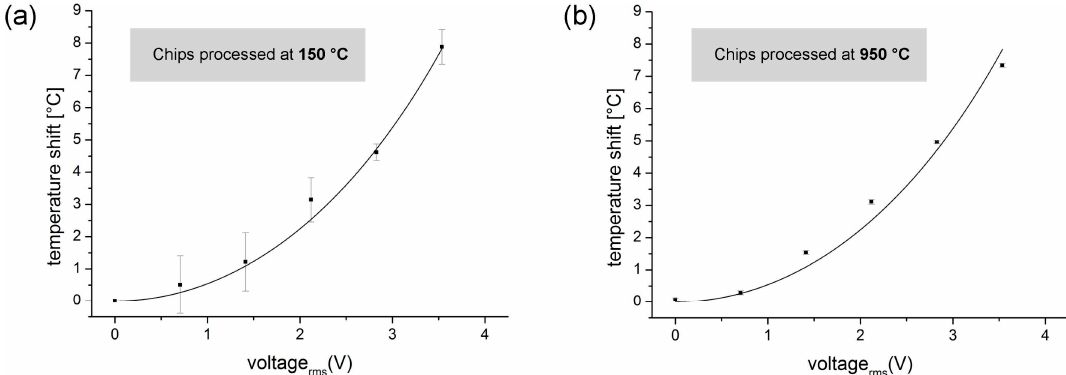
Figure 3. Voltage dependency of the Joule heating induced temperature shift (°C) in the octupole cage of ( a ) adhesive-based bonded and ( b ) direct fusion-bonded LOC devices. The octupole cages were operated in RotX mode. The solid line represents the fitting with Equation (8) and a calculated k parameter of 0.54 ( a ) and 0.53 ( b ). All fluorescence measurements were done fivefold and normalized to fluorescence intensities at 25 °C. Standard deviations of the LOC devices differed due to the fact that the Rhodamine B fluorescence intensities were measured with different microscopic systems. The exposure to fluorescence irradiation was manually executed in case of the adhesive-based bonded LOC device, whereas the exposure was automatically performed for measurements with the direct fusion-bonded LOC device.